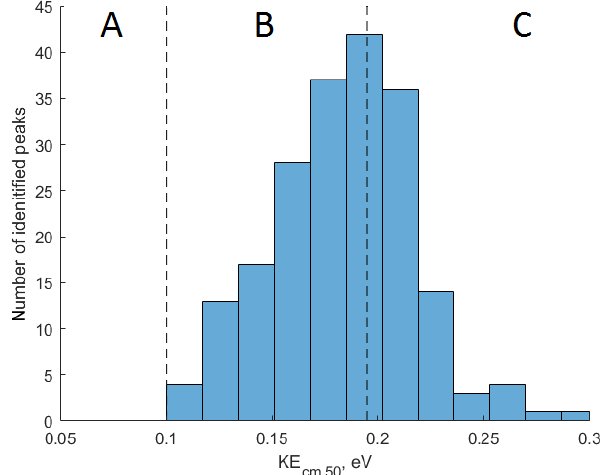
Figure 6. Comparison of volume mixing ratios of SOA components Figure 5. Application of the collision-induced dissociation tech- detected by the CIMS instrument in both H 3 O + and NH + niques for measurement of SOA composition produced during pho- in the photooxidation experiment of 3-methylcatechol. tooxidation of 3-methylcatechol in a laboratory experiment. A total of 202 peaks are detected in NH + mode and binned based on their 4 KE cm50 . Molecules with KE cm50 smaller than 0.10eV cannot be detected by NH + CIMS (region A); sensitivities of molecules char- 4 acterized by KE cm50 between 0.10 and 0.19eV (region B) can be calculated using the linear fit presented in Fig. 4; molecules with KE cm50 greater than 0.19eV are detected at the “kinetic sensitiv- ity” (region C).